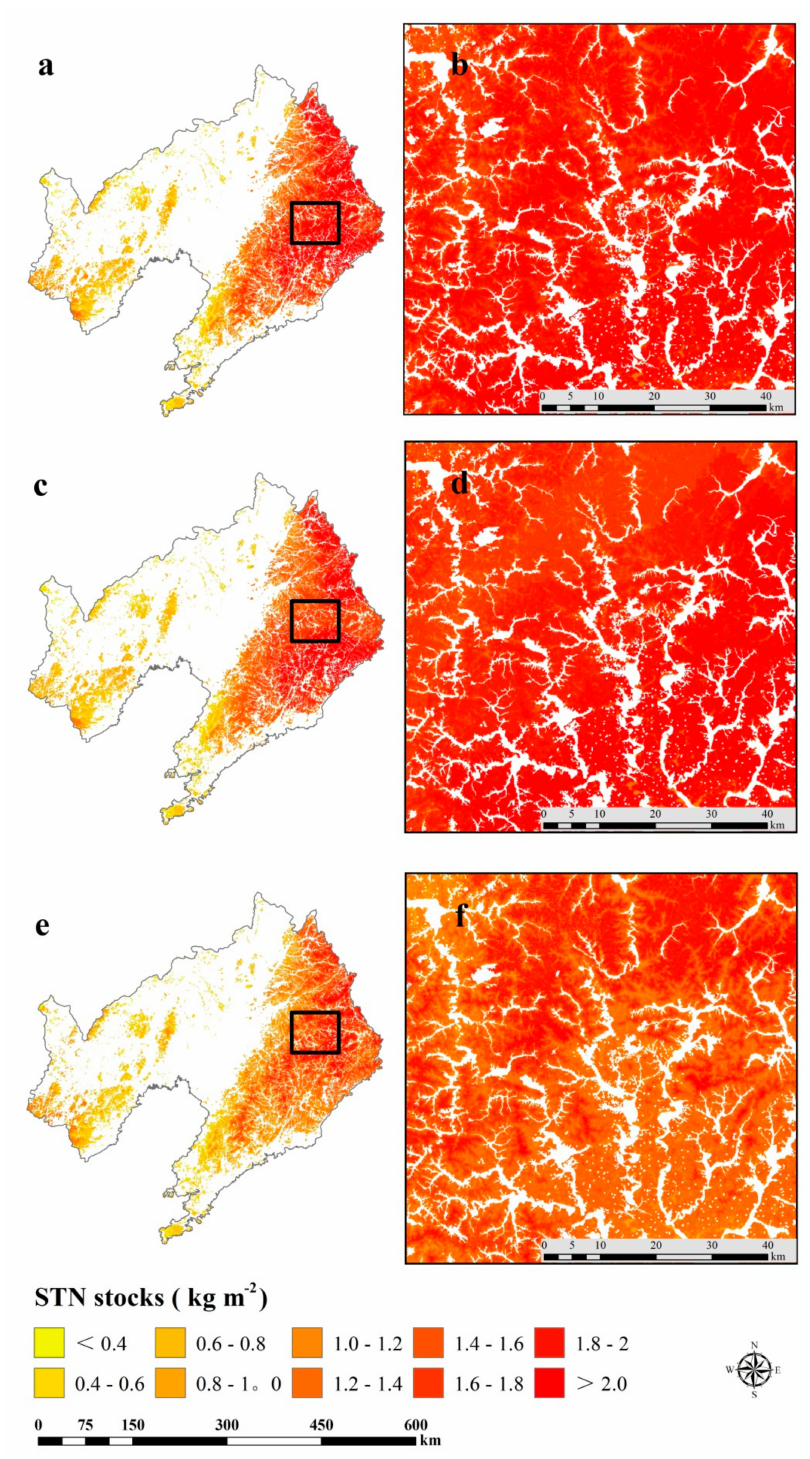
Figure 8. Spatial distribution of the predicted topsoil (0–30 cm) soil total nitrogen (STN) stocks with models of geographically weighted regression (GWR) ( a , b ), multiple stepwise linear regression (MSLR) ( c , d ), and boosted regression trees (BRT) ( e , f